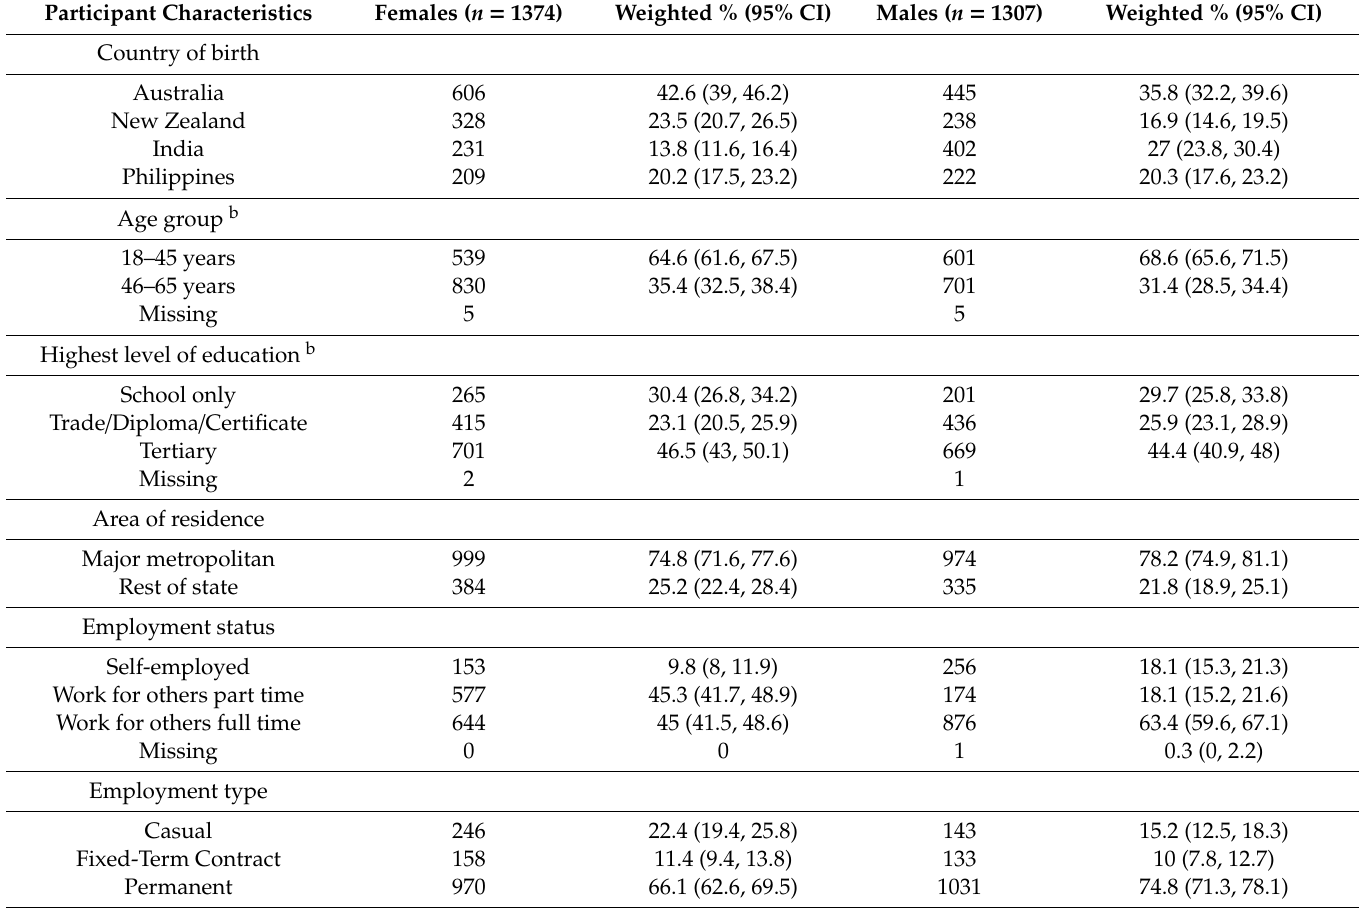
Table 1. Unweighted number and weighted prevalence estimates with 95% Confidence Intervals a for participant sociodemographics and employment status by